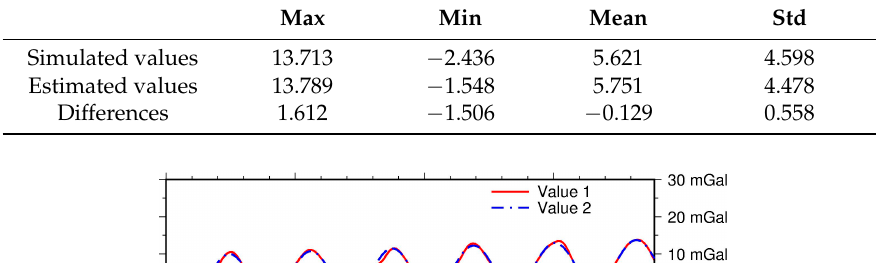
Table 4. The statistics of the systematic errors in the Tibetan Plateau (mgal).